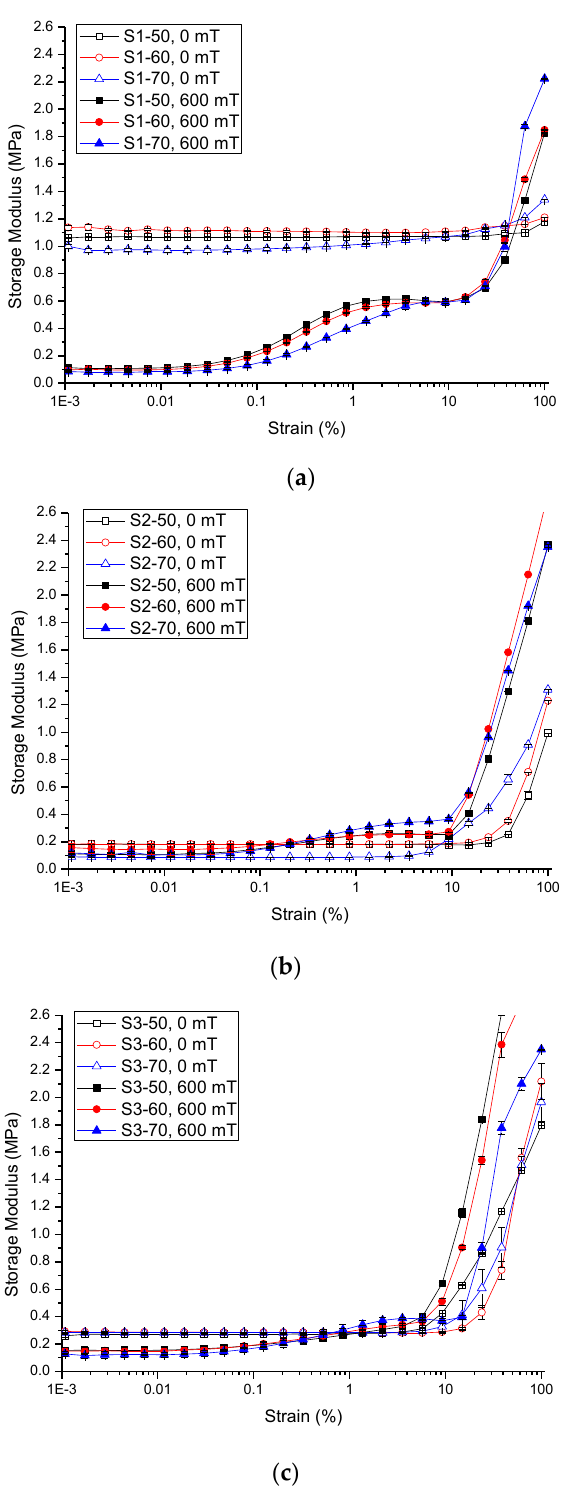
Figure 5. The dependencies of loss factor ( a ) Sample 1, ( b ) Sample 2 and ( c ) Sample 3 as a function of strain amplitude. (* at constant frequency, f = 1 Hz ).